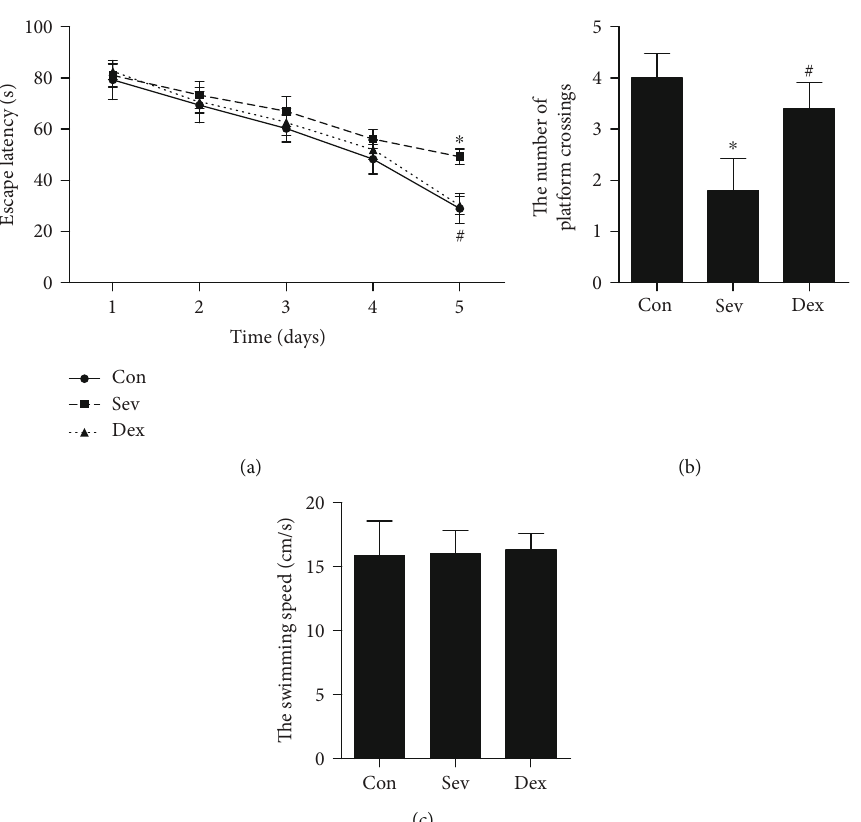
Figure 1: Dexmedetomidine alleviated the decline in learning and memory ability during puberty after sevo fl urane exposure in developing rats. (a) The escape latency. (b) The number of crossing platforms on the sixth day. (c) Swimming speed. ∗ Compared with the control group, P < 0 : 05 . # Compared with the Sev group, P < 0 : 05 .